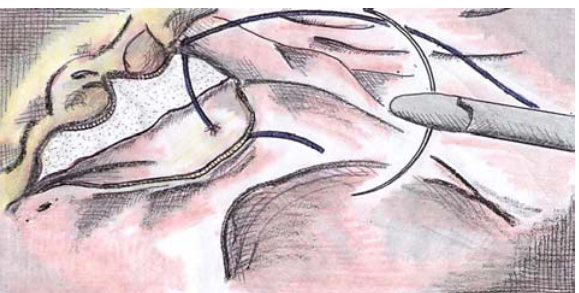
Figure 1 – Diaphragmatic lesion repaired with intracorporeal